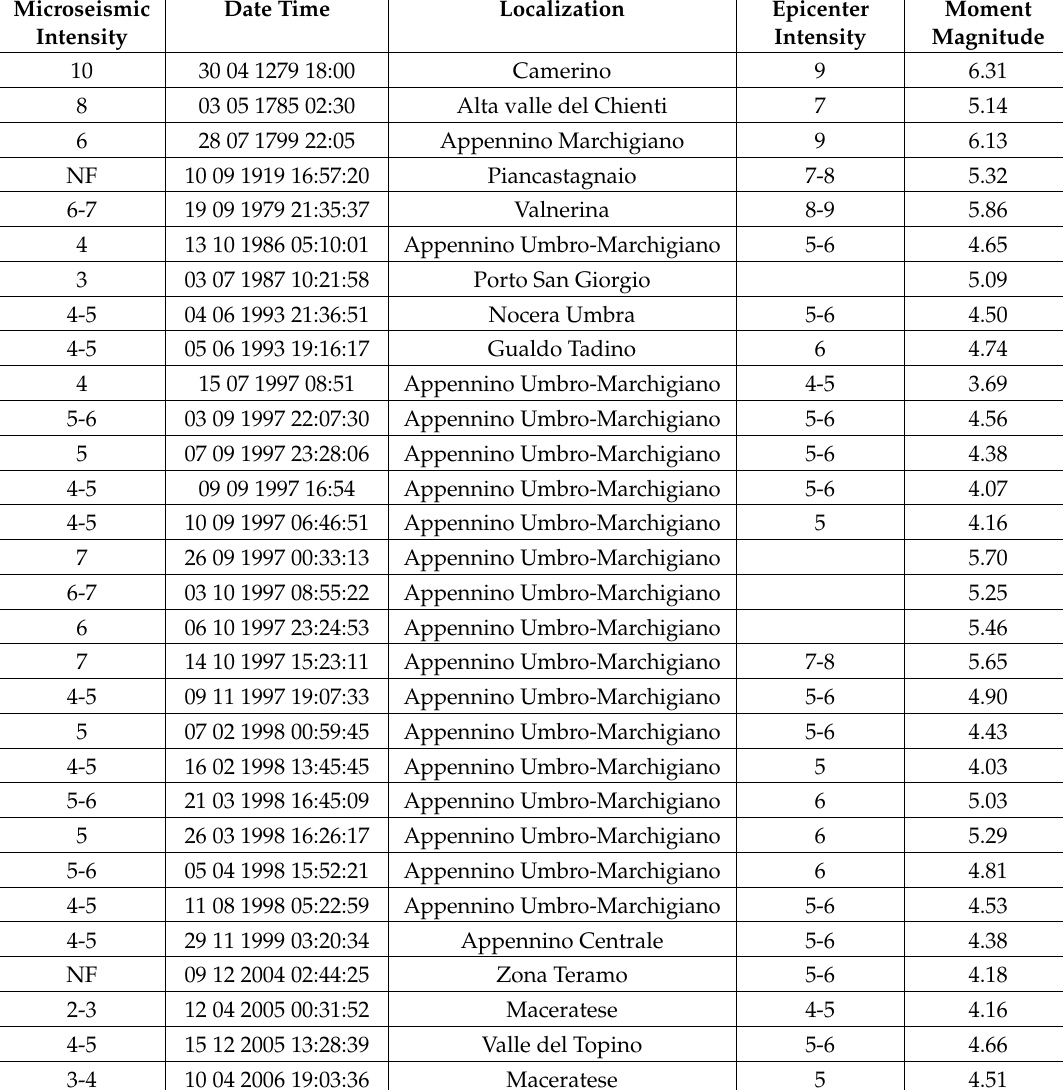
Table 1. Table of major seismic events for the Serravalle di Chienti area. Data source [44].